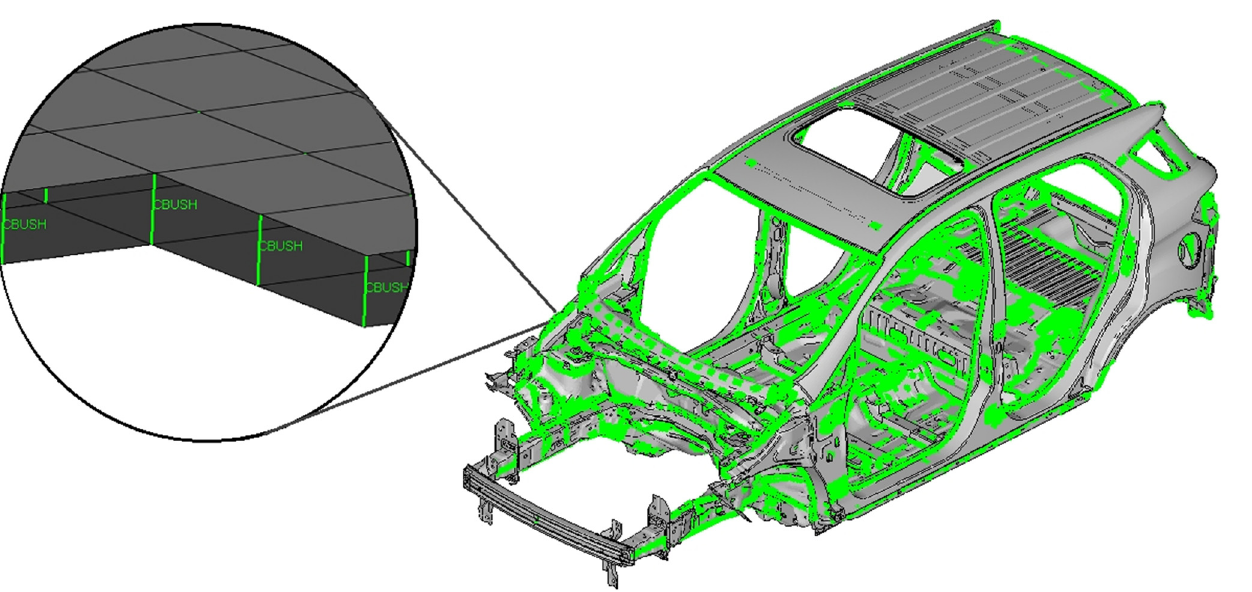
Figure 10. Adjusted linear FE model showing the added spring-damper elements.